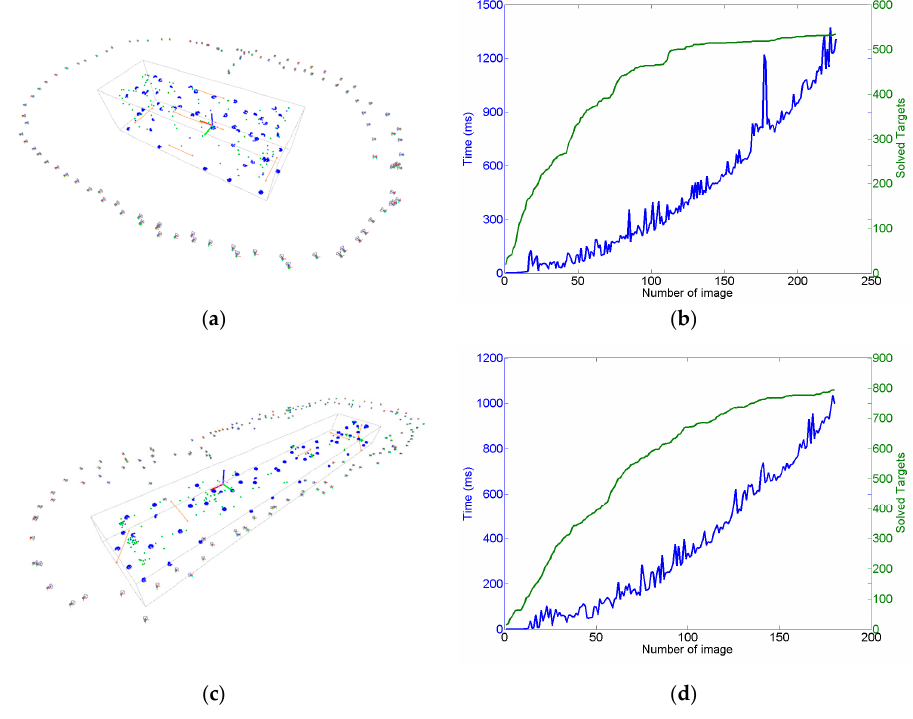
Figure 16. Measurement results ( a , c ) in large raw parts for industrial examples shown in Figure 15a,c and Figure 15c respectively, where solved target 3D coordinates and camera views are jointly